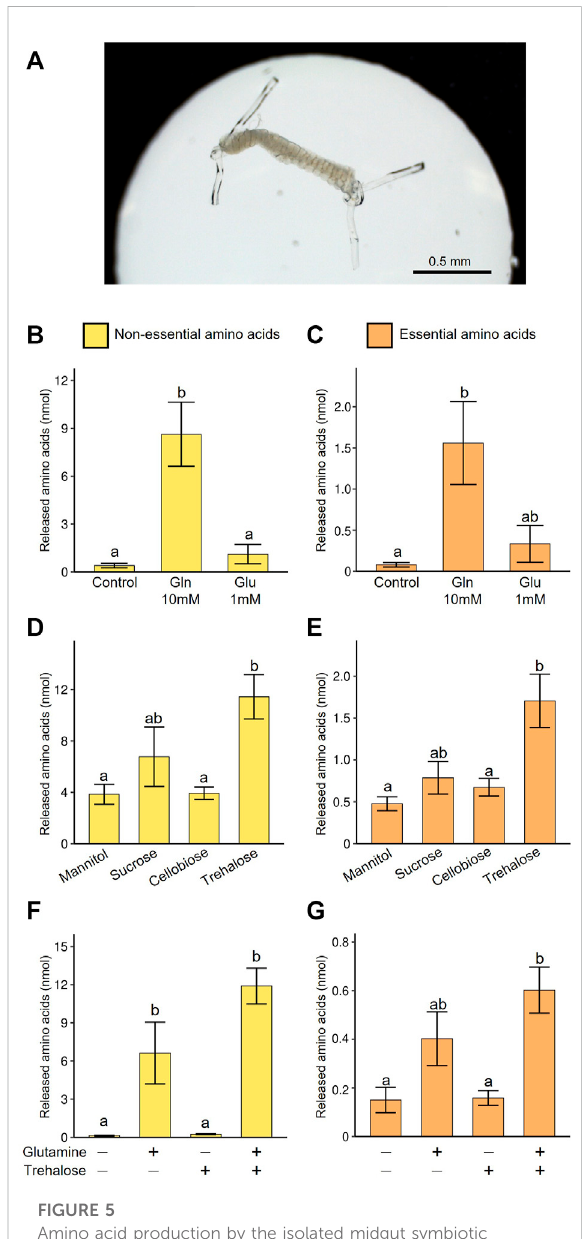
FIGURE 5 Amino acid production by the isolated midgut symbiotic organ of M. punctatissima . (A) An isolated symbiotic midgut in a medium drop. (B,C) Effect of nitrogen sources (10 mM glutamine or 1 mM glutamate) on production of non-essential amino acids (B) and essential amino acids (C) in the presence of 200 mM trehalose. (D,E) Effect of sugar sources (200 mM mannitol, sucrose, cellobiose, or trehalose) on production of non-essential amino acids (D) and essential amino acids (E) in the presence of 10 mM glutamine. (F,G) Synergetic effects of sugar (200 mM trehalose) and nitrogen (10 mM glutamine) sources on production of non-essential amino acids (F) and essential amino acids (G) . Means ± s.e.m are shown ( N =4). Different letters(a, b) on thebars indicate statistically signi fi cant differences ( p < 0.05, likelihood ratio test for GLM and posthoc multiple